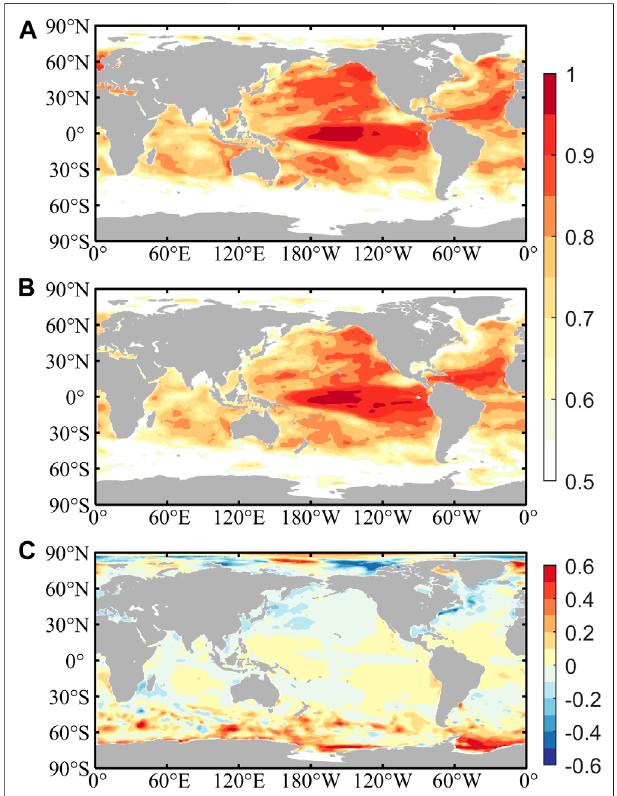
FIGURE 3 | The SSTA ACC between the COBE SST and the initial conditions. (A) FIO-CPS v1.0; (B) FIO-CPS v2.0; and (C) FIO-CPS v2.0 – FIO- CPS